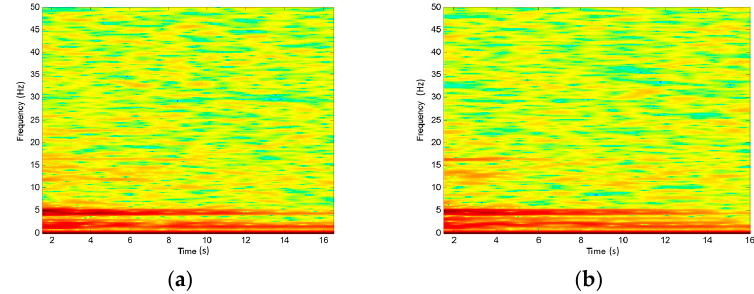
Figure 9. Spectrogram. ( a ) Tiltmeter 1 reading; ( b ) Tiltmeter 2 reading.